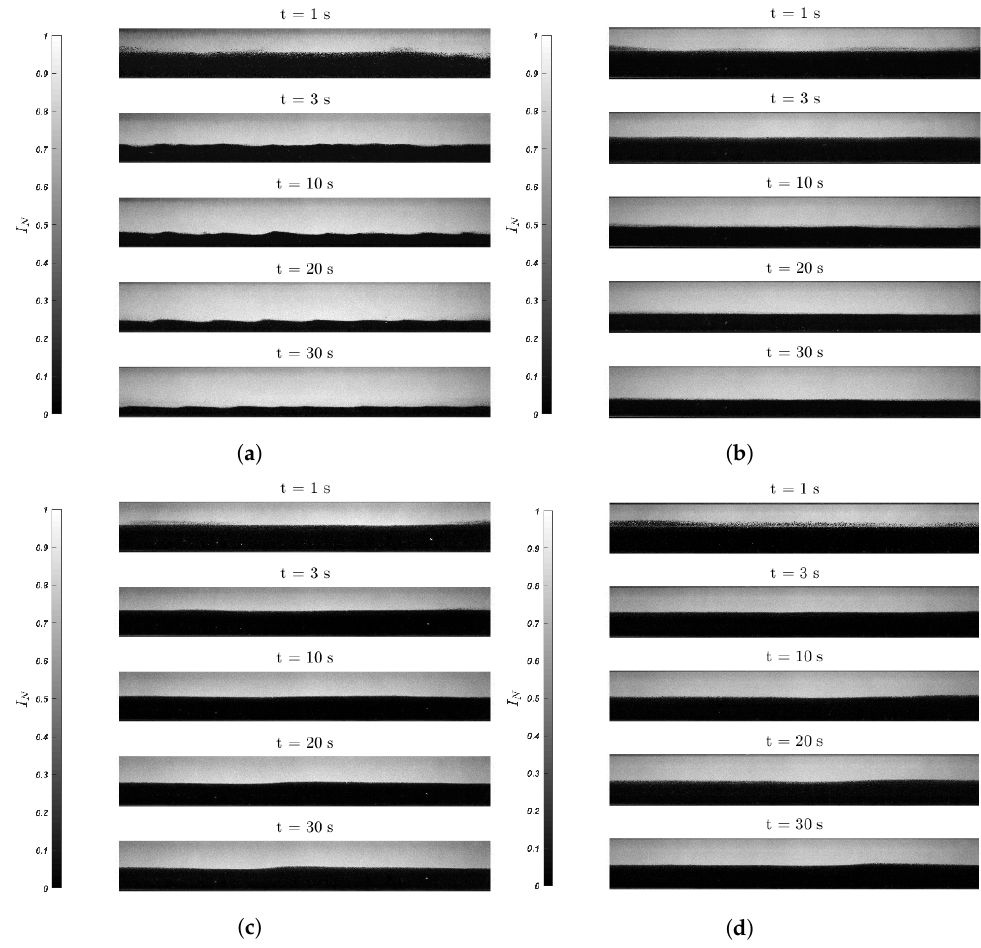
Figure 5. Displacement of Carbopol with ( a ) water in the turbulent regime (Experiment 1), ( b ) 0.5% xanthan solution in the laminar regime (Experiment 2), ( c ) 0.25% xanthan solution in the transitional regime (Experiment 3), and ( d ) 0.125% xanthan solution in the low Reynolds turbulent regime (Experiment 4), at full eccentricity.